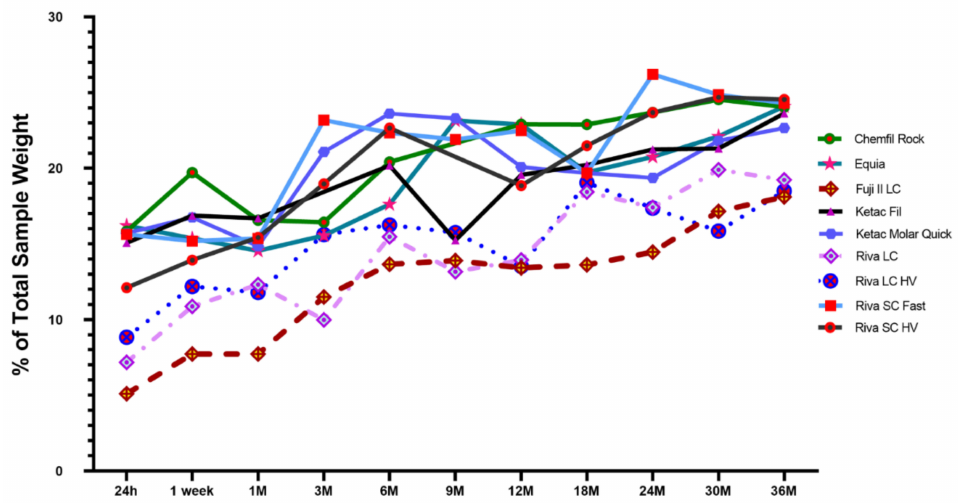
Figure 2. Mean Unbound Water Content (%). n = 12; Unbound water loss calculated as a percentage of total sample